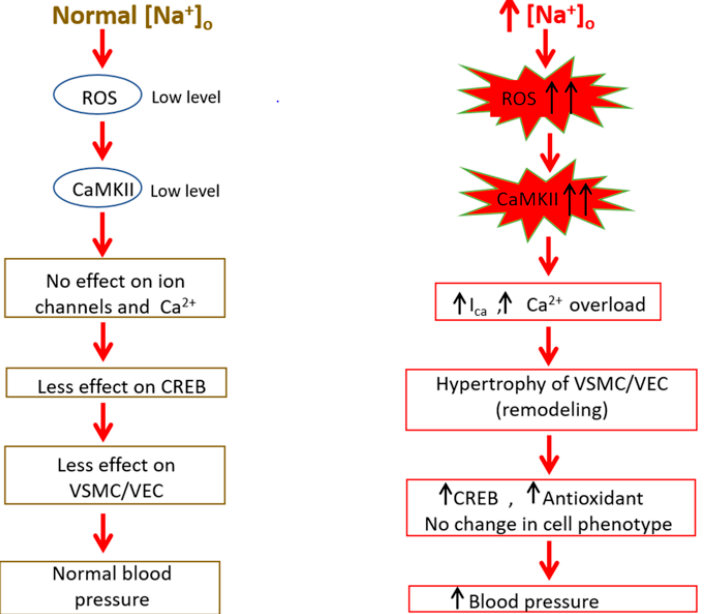
Figure 2. Schematic representation summarizing the literature in the field showing that chronic high salt induced an increase in the intracellular levels of ROS (reactive oxygen species) and activation of CaMKII (calmodulin kinase II) and cyclic AMP response element binding protein (CREB). I Ca : L-type Ca 2+ channels; [Na + ] o: extracellular Na + concentration.